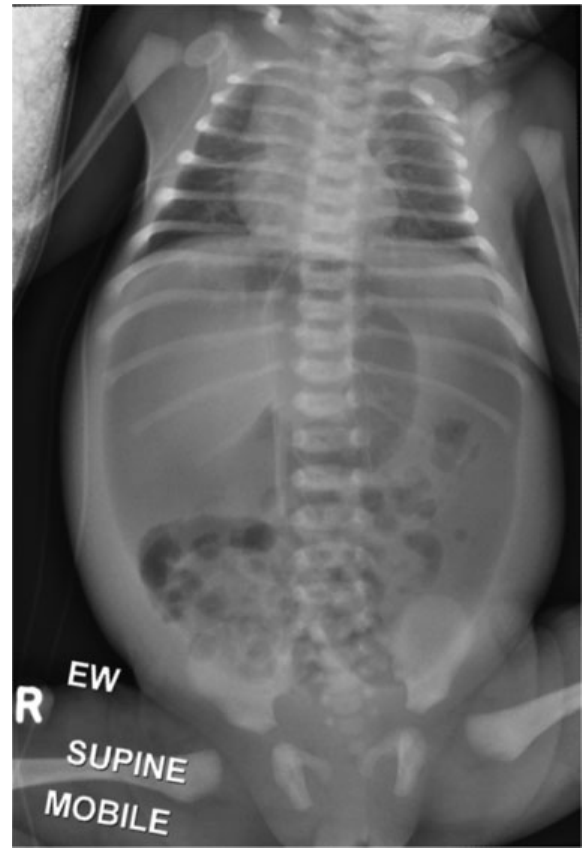
Fig. 1 Supine plain abdominal fi lm with evidence of free air in the peritoneal cavity.